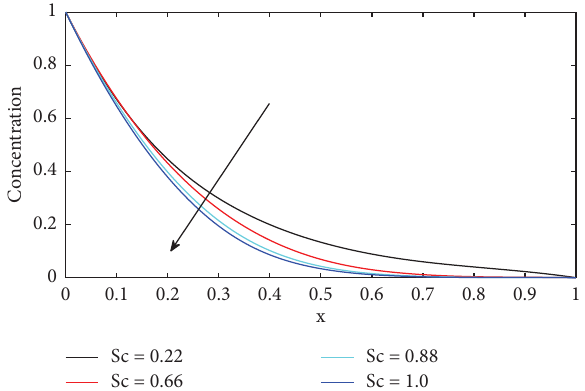
Figure 12: Induced magnetic feld profles for diferent values of Prm.